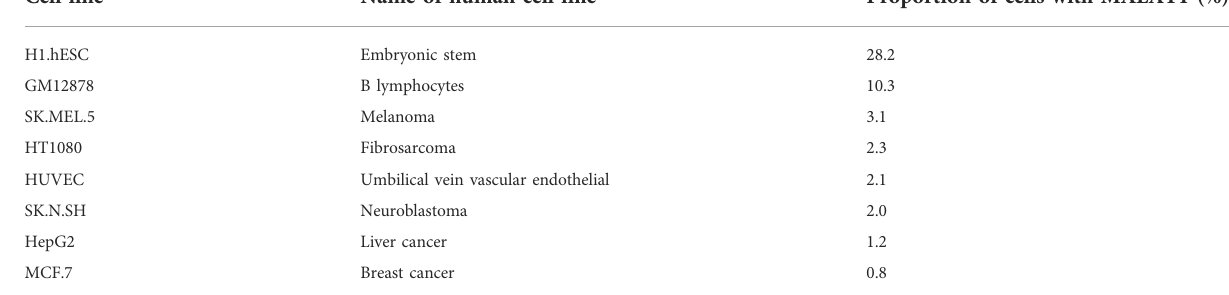
TABLE 2 Presence of MALAT1 in various cell